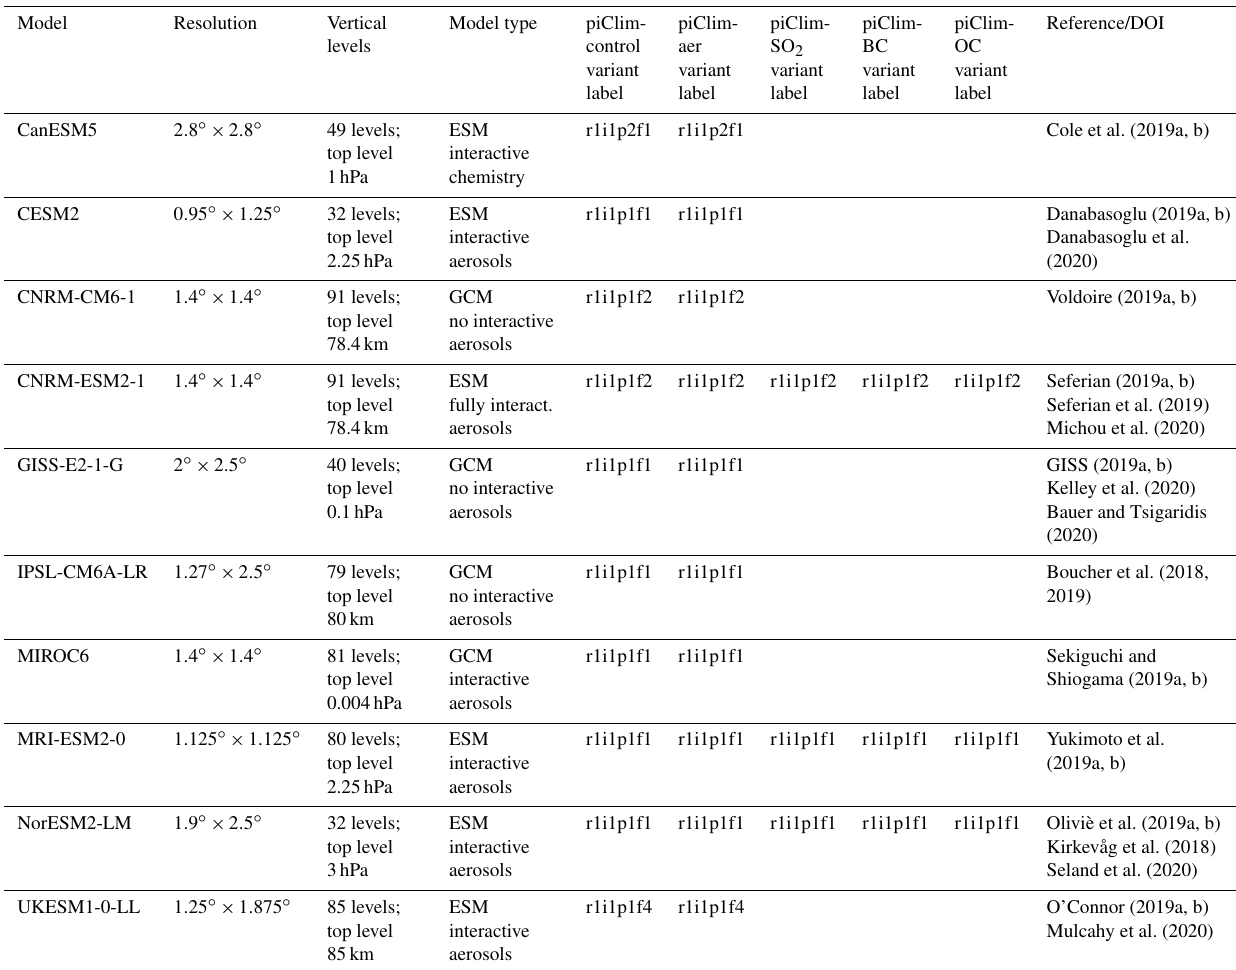
Table 1. Information on model resolution, vertical levels, type, simulations and references. Each experiment has a variant label that resembles the following: r < k > i < l > p < m > f < n > , where k is the realization_index, l is the initialization_index, m is the physics_index and n is the